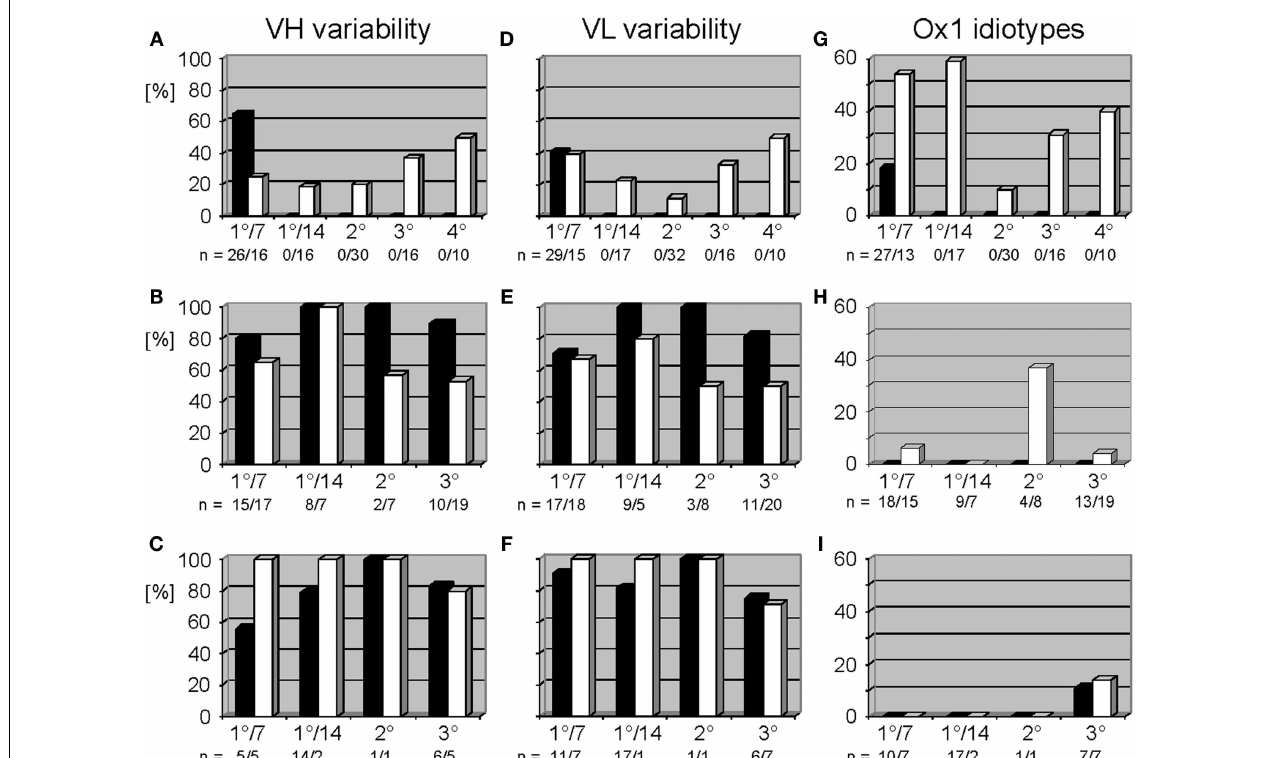
( Figure 1F ), even though none of them included the Id Ox1 V gene combinationofV H Ox1/V κ Ox1,whichisdesignatedV H 171/V κ 072 in the integrative database VBASE2.